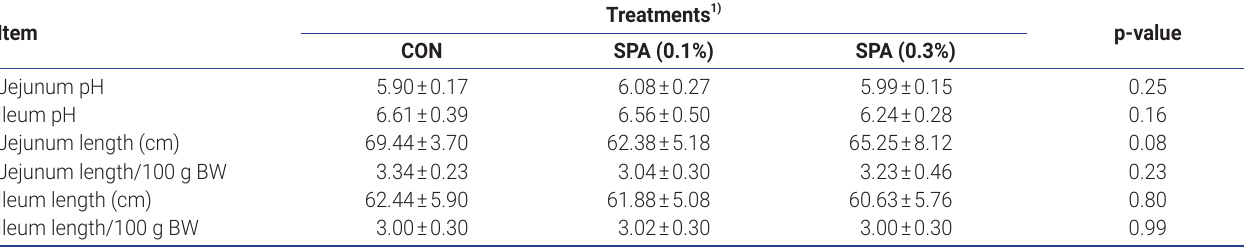
Table 8. Effect of supplementary SPA on the length and pH of ileum and jejunum in laying